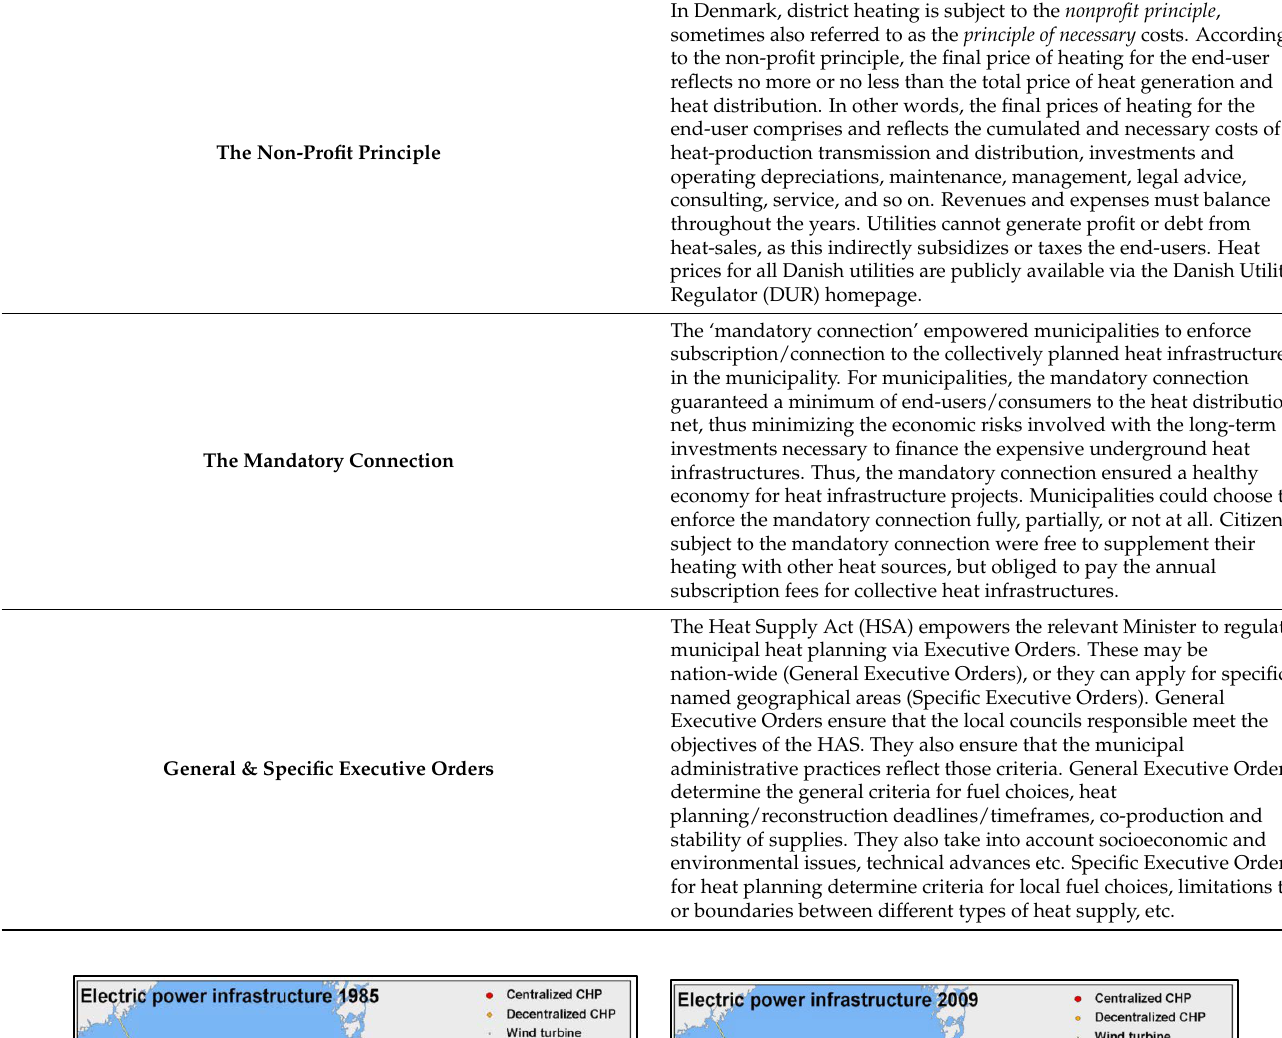
Table 2. The three key legal principles from the Danish Heat Supply Act. Source: [59].